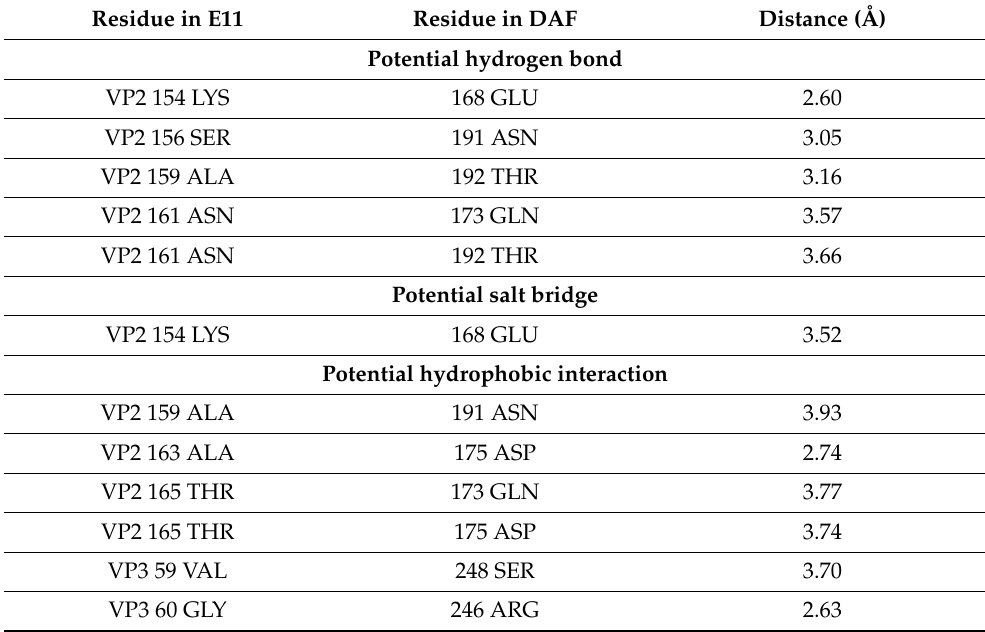
Table 2. List of protein interactions between E11 and